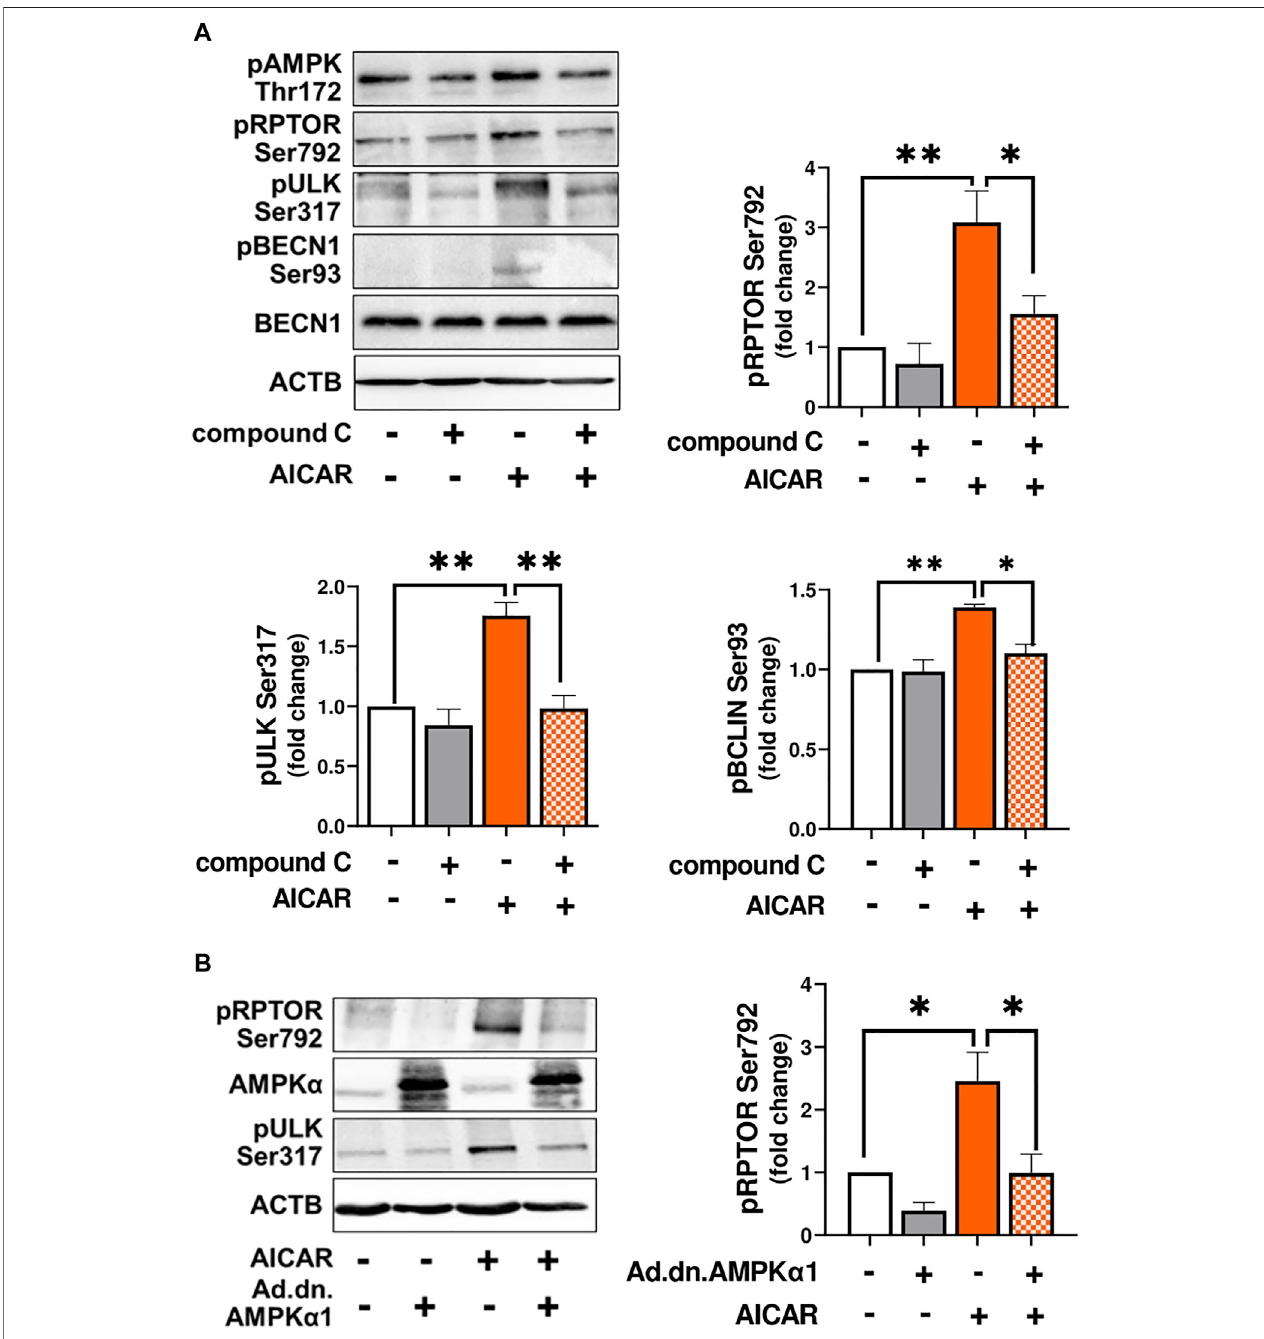
FIGURE 3 | AMPK triggers post-translational modi fi cation of proteins involved in autophagy initiation. (A) Small luteal cells were pretreated with compound C (50 μ M) for 1 h and then treated with AICAR (1 mM) for 15 min. Bar graphs and representative blots showing levels of phospho-AMPK α (Thr172), RPTOR (Ser792), ULK1 (Ser317), BECN1 (Ser93) and total BECN1. (B) Small luteal cells were infected with control adenovirus (Ad.CMV) or adenovirus expressing dominant negative AMPK α 1 (Ad.dn.AMPK α 1) for 48 h and then treated with AICAR (1 mM) for 15 min. Bar graphs and representative blots showing levels of phospho-RPTOR (Ser792), ULK1 (Ser317) and total AMPK α . Data are shown as a fold change and presented as means ± SEM from three-four separate experiments. Data were normalized to β -actin (ACTB). Statistical analysis was performed using one-way ANOVA test with post hoc Bonferroni test. Signi fi cant differences between treatments are indicated with asterisks * and ** re fl ecting p < 0.05 and p < 0.01.